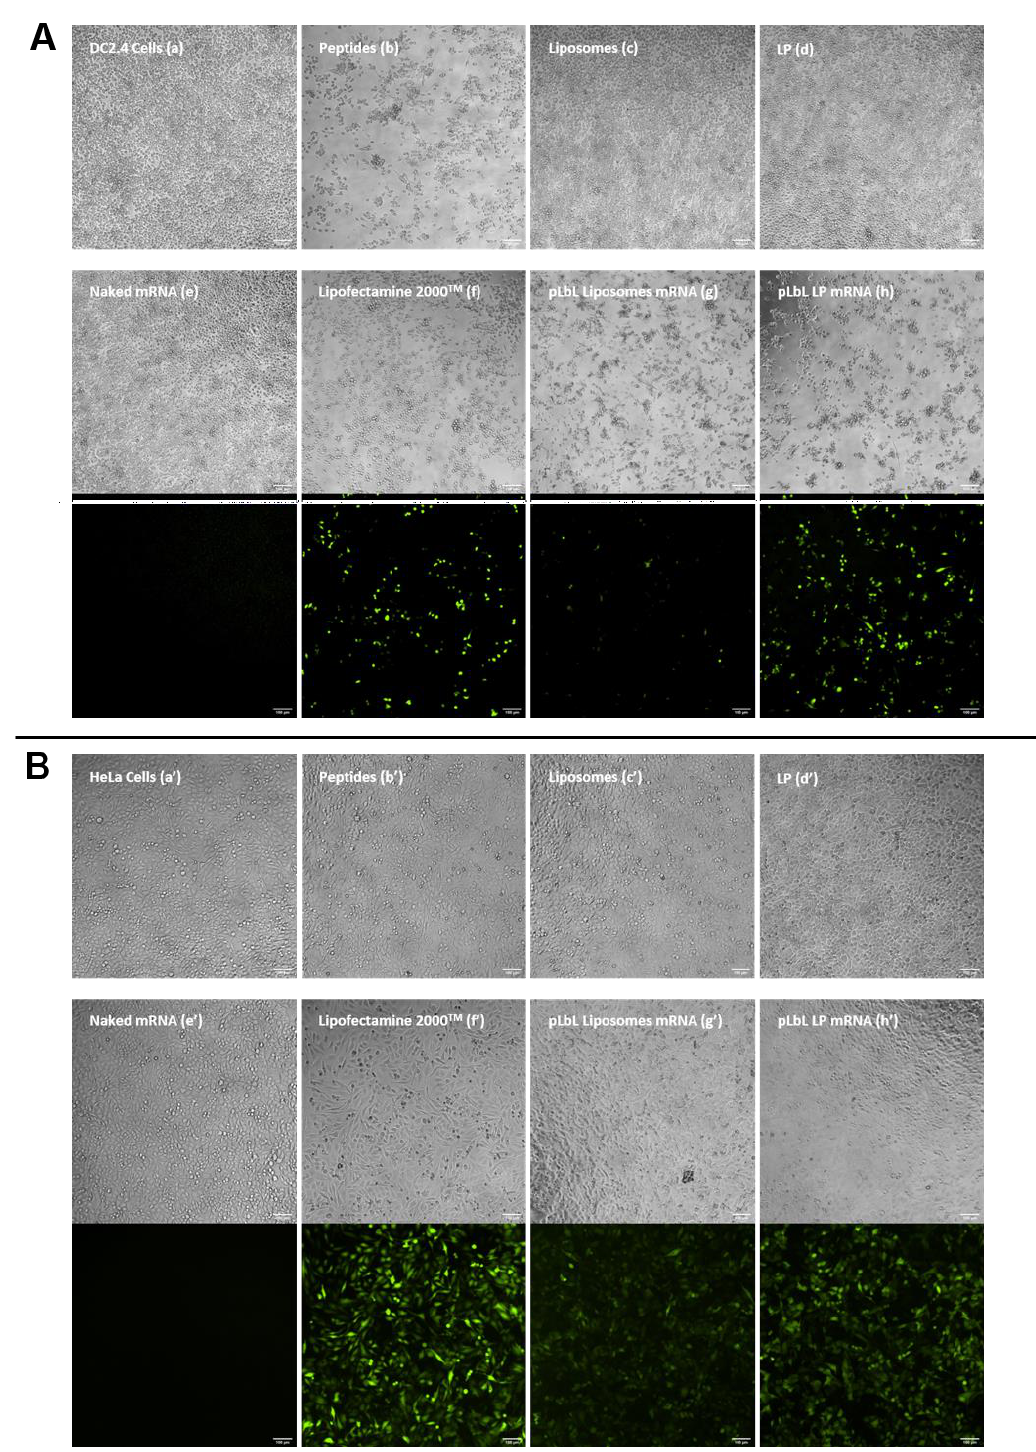
Figure 5. In vitro assessment of (top images) the cytotoxicity (normal phase mode) and (bottom images) transfection efficiency (fluorescent mode) of pLbL formulations using microscopy. Images taken 24 h after transfection of 90 ng eq. of eGFP mRNA, formulated either in liposomes or in LP using pLbL strategy (ratio mRNA/LAH4-L1 = 1:20 w / w ) on DC 2.4 (( A ), ( a – h )) and HeLa (( B ), ( a’ – h’ )) cells. Lipofectamine 2000 TM was used as positive control. Scale bar: 100µm. (a,a’) Cells alone (b,b’) LAH4-L1 peptide (c,c’) Liposomes, (d,d’) LP (e,e’) Naked mRNA (f,f’) Lipofectamine 2000 TM (g,g’) pLbL Liposomes mRNA (h,h’) pLbL LP mRNA.